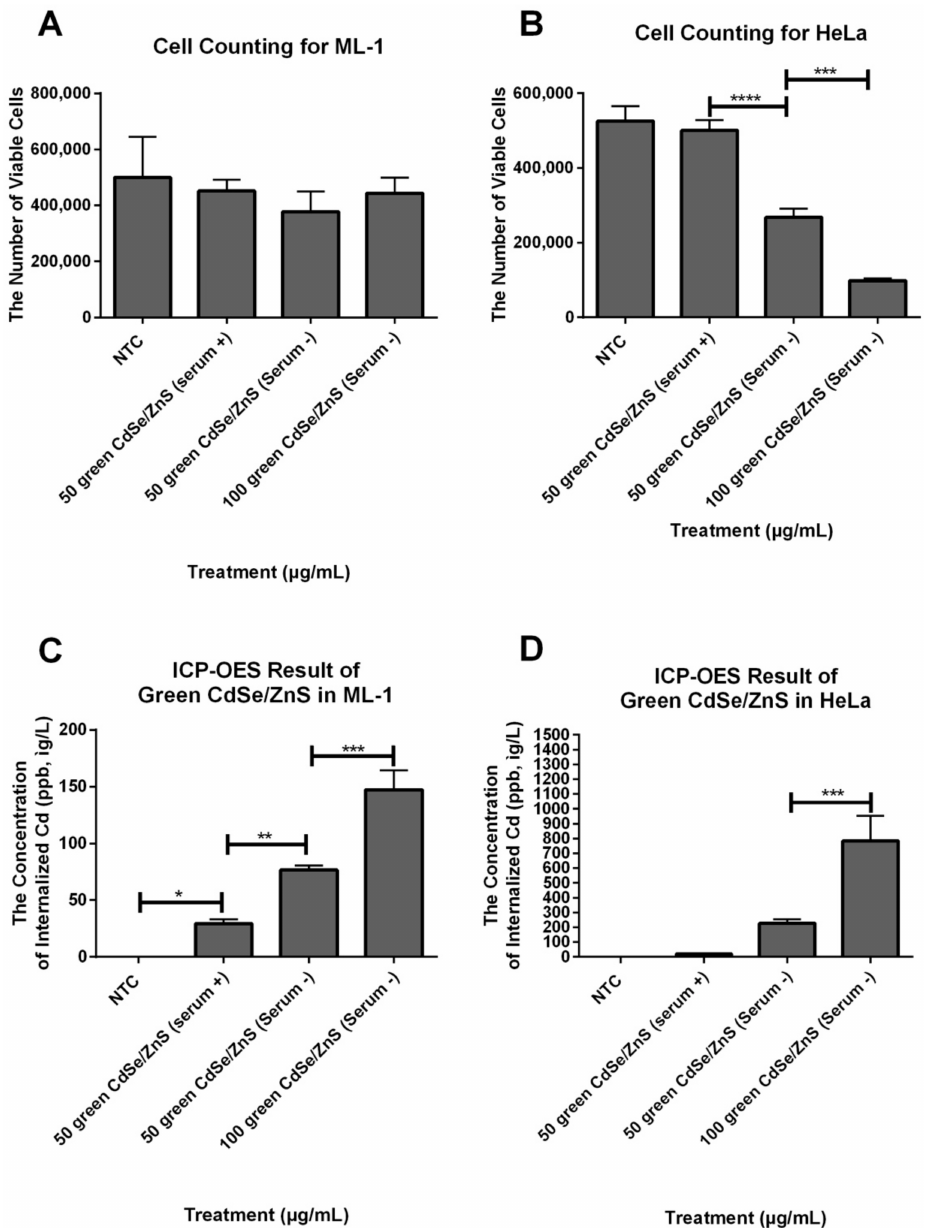
Figure 10. The concentration of internalized QDs by ML-1 and HeLa cells treated with 50 and 100 µ g/mL green CdSe/ZnS in serum+ and − mediums for 48 h. ( A ) The number of viable ML-1 cells that were treated with 50 and 100 µ g/mL green CdSe/ZnS QDs in serum+ and − mediums after 48 h. ( B ) The number of viable HeLa cells that were treated with 50 and 100 µ g/mL green CdSe/ZnS QDs in serum+ and − mediums after 48 h. ( C ) The concentration of internalized QDs by ML-1 that were treated with 50 and 100 µ g/mL green CdSe/ZnS QDs in serum+ and − mediums after 48 h. ( D ) The concentration of internalized Cd by HeLa that were treated with 50 and 100 µ g/mL green CdSe/ZnS QDs in serum+ and − media for 48 h. Statistically significant results are indicated based on p -values: * = p < 0.0133, ** = p < 0.01, *** = p < 0.001, **** = p <